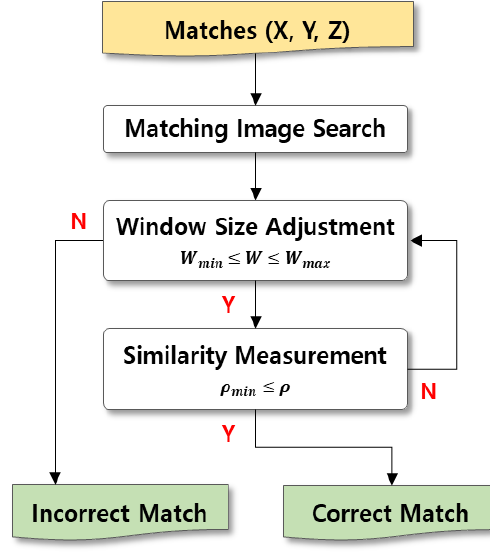
Figure 1. Workflow of the proposed